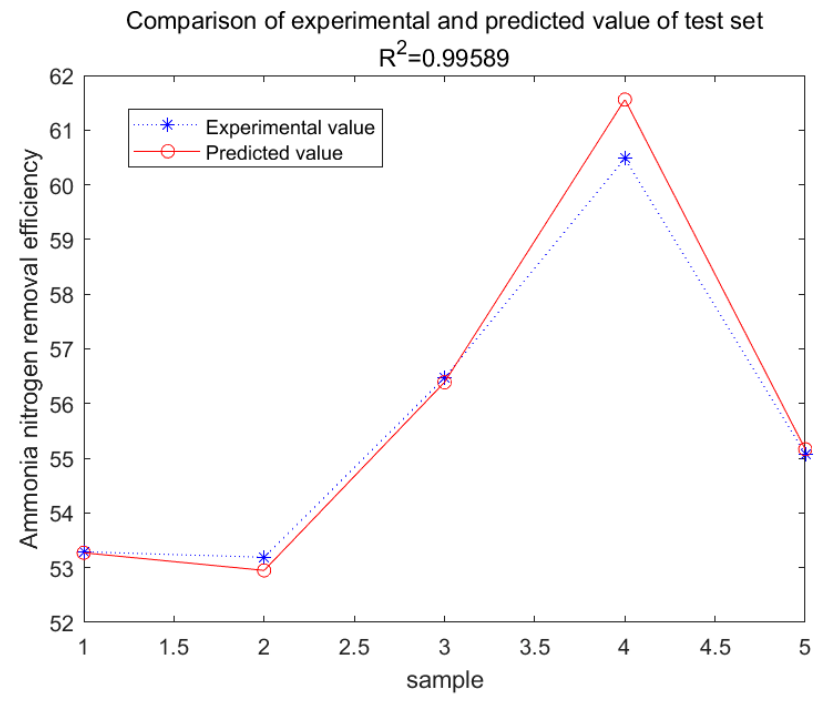
Figure 12. Comparison of experimental and predicted value of test set.